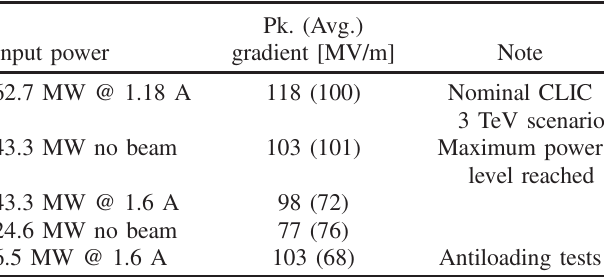
TABLE III. Gradient parameters in the different testing con- ditions and the CLIC 3 TeV scenario. It is important to note that the tests were conducted at lower power than the 3 TeV CLIC conditions.